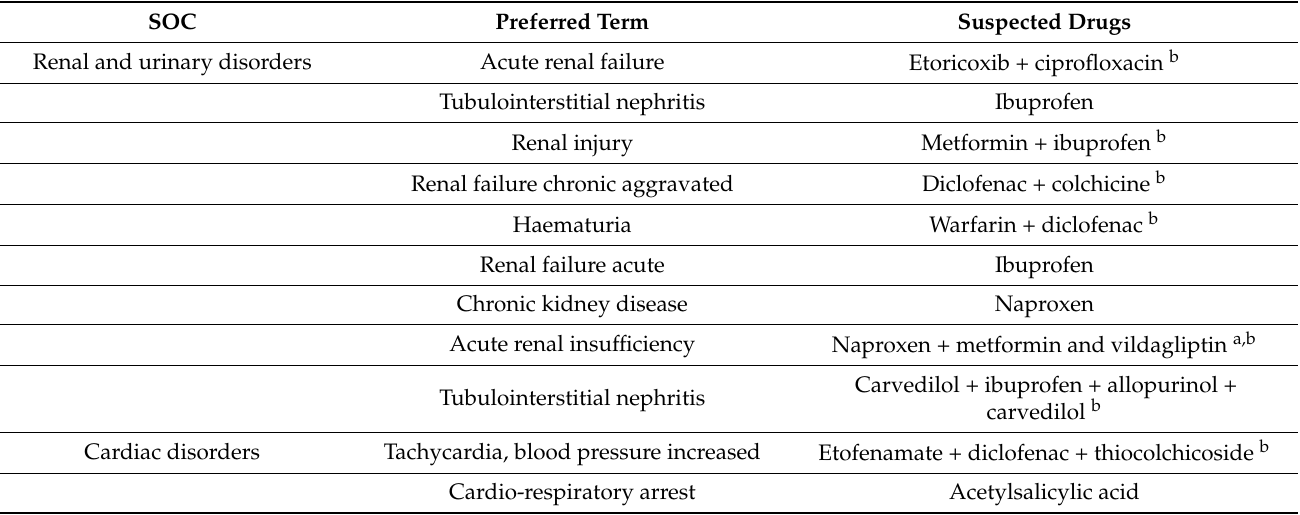
Table 3. Non-steroidal anti-inflammatory drugs and other class of drugs associated to serious renal events and cardiac disorders where occurred adverse reaction that resulted in life-threatening adverse event, caused patient hospitalization or prolonged